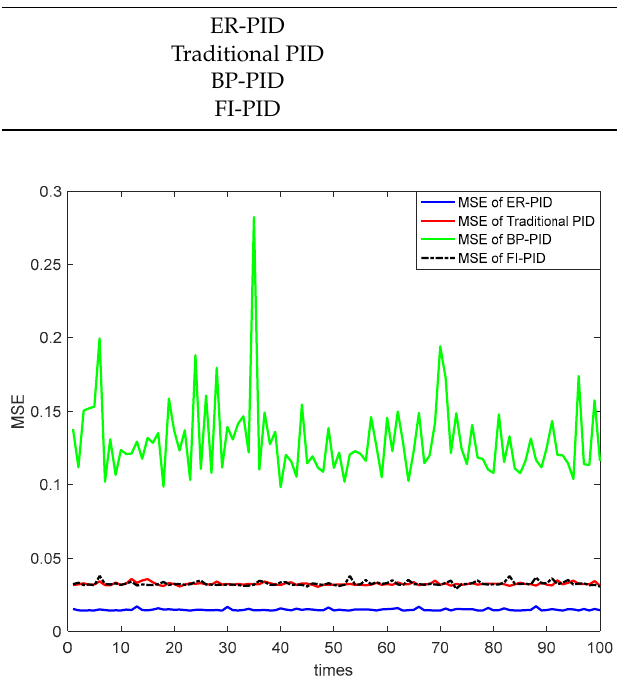
Table 15. Mean value of the tracking MSE for the 5 methods after a random perturbation. Methods of Shaft Speed Control